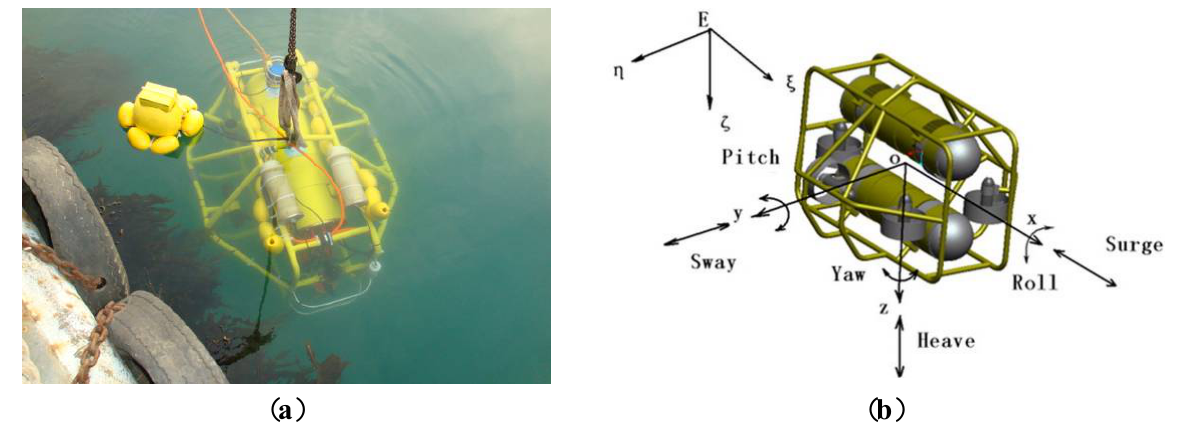
Figure 1. ( a ) C-Ranger is in deployment. ( b ) The coordinate system of C-Ranger